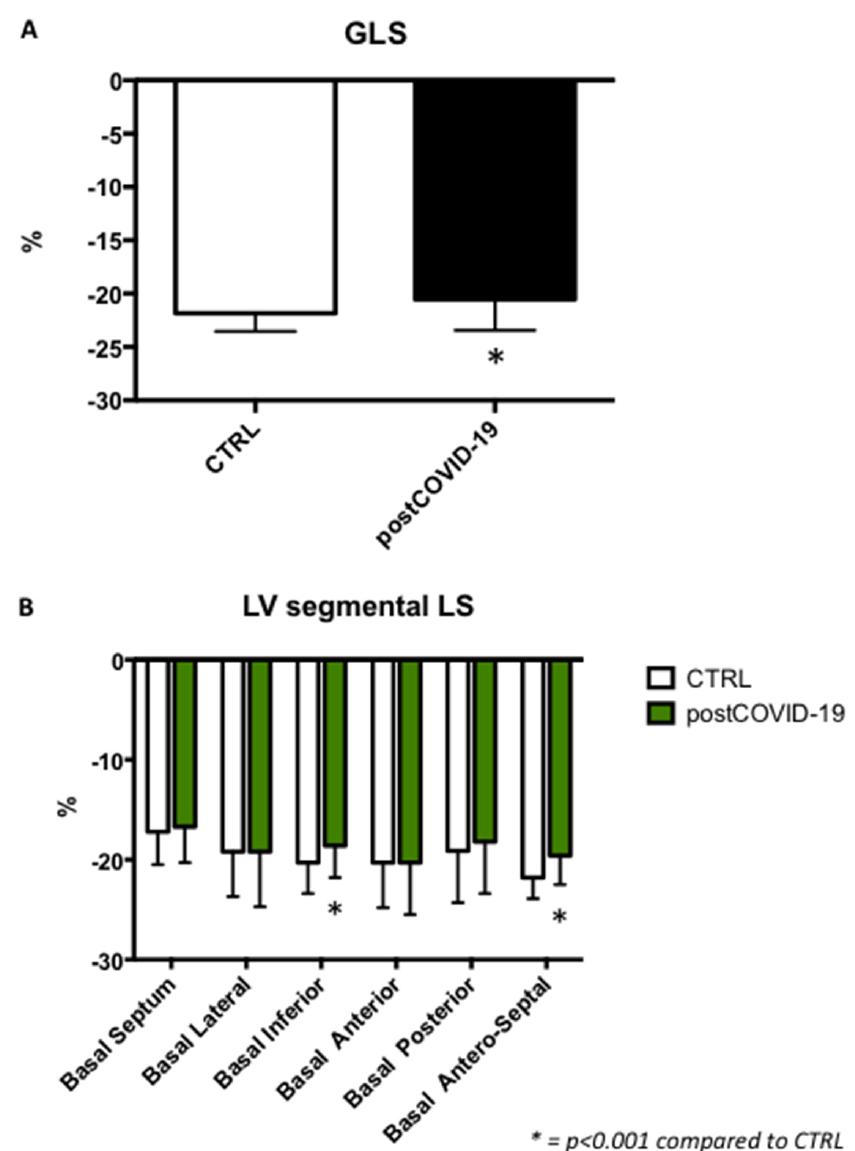
Figure 1. Global longitudinal strain in children belonging to the post-COVID-19 group compared to controls ( A ). Basal segmental analysis in post-COVID-19 group compared to controls ( B ).